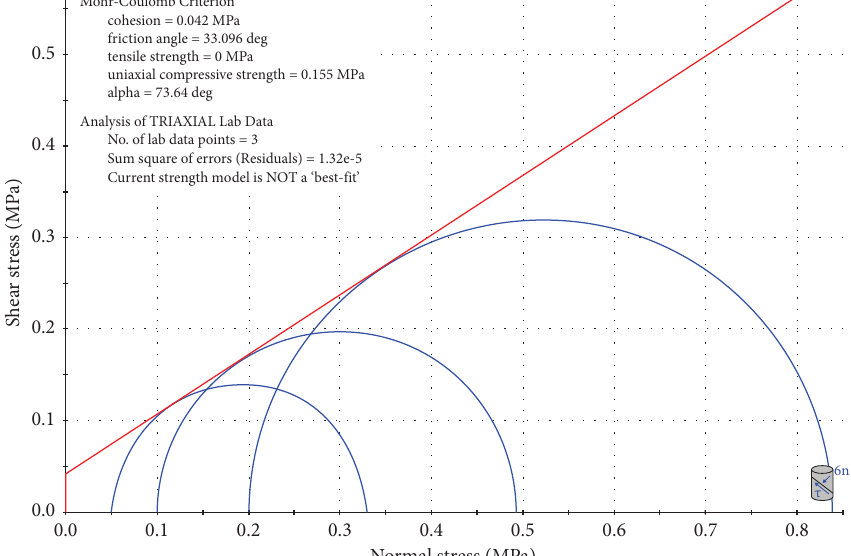
Figure 16: Shear strength variation against the normal stress-saturated condition CR8 (cement RHA 1:2 and 8% lime content), 28 days of curing, from numerical modelling plotted by RocData. Table 6: Comparison between cohesion and internal friction angle obtained from the triaxial test and numerical simulation. Triaxial test Numerical test Sample Cohesion (kPa) Internal friction ( ϕ ) Sample Cohesion (kPa) Internal friction ( ϕ